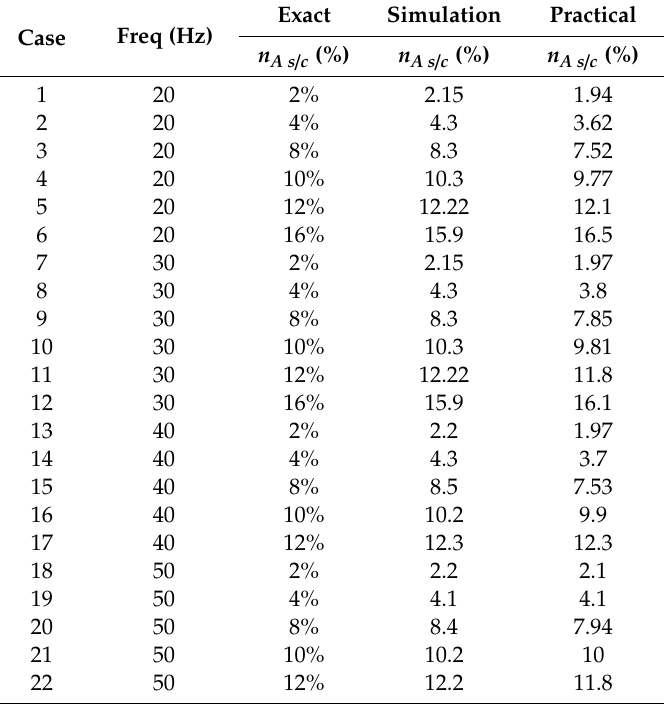
Table 2. EKF estimation response with di ff erent frequencies at constant load current in phase